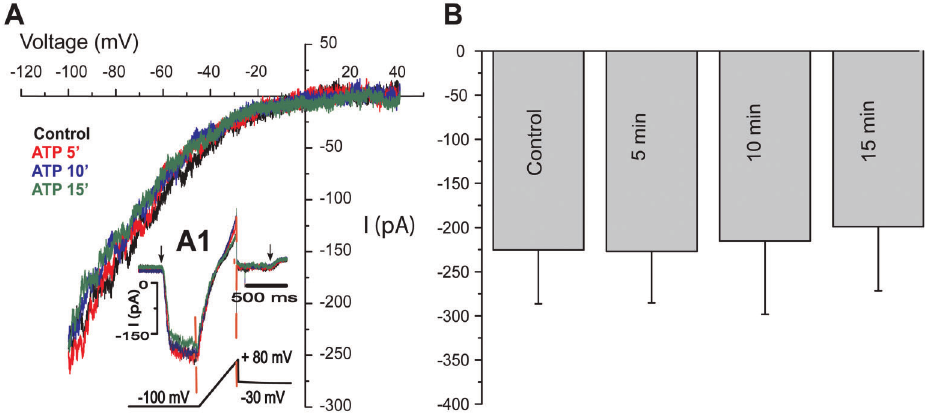
Figure 1. ATP-evoked currents did not show signi fi cant desensitization under the present experimental conditions. A , Current-voltage (I (cid:2) V) plot obtained in response to 100 m M ATP application in control condition ( fi rst application - black) and after 5 (red), 10 (blue), and 15 min (green). The inset shows the voltage protocol used as well as the total current response. Note that application of ATP (arrows), with the cell held at – 100 mV, induces a fast activating inward current. At the peak of the current response a voltage ramp going from – 100 to + 80 mV, with 500 ms duration, was applied and this corresponds to the IxV plot shown. The plot displays the response up to + 40 mV only, because other currents start to activate beyond this point. This same procedure was used in all other experiments. B , Bar graph showing the means ± SE of currents measured at – 70 mV (n=7 cells). The cells were continuously superfused with control solution between ATP pulses. P X 0.05, ANOVA and Tukey post-test.